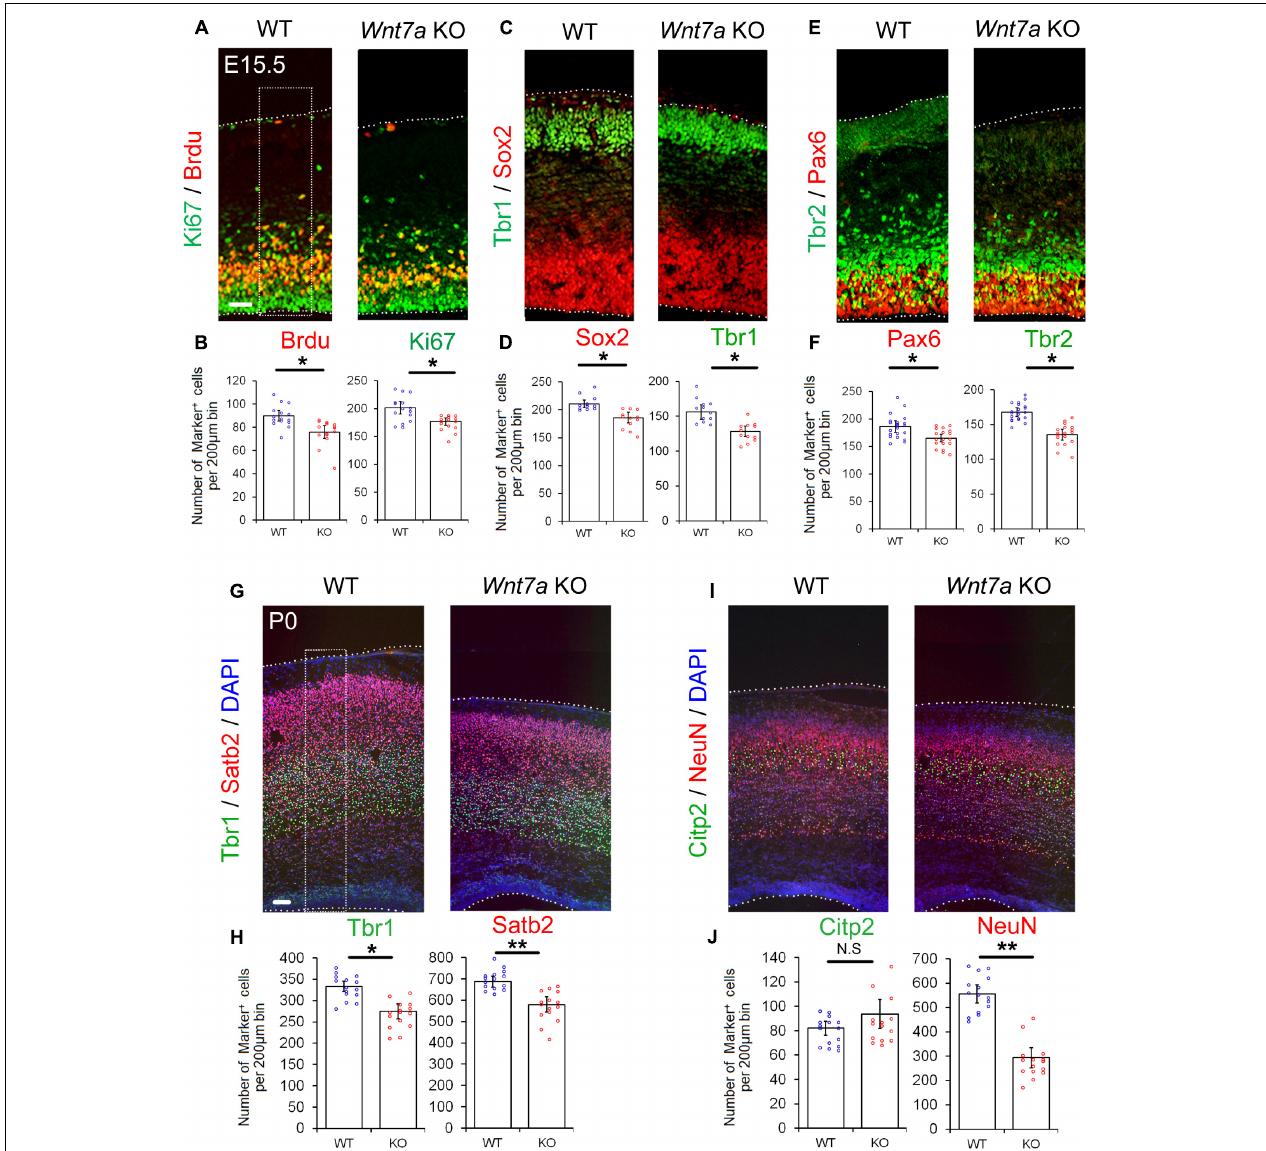
FIGURE 3 | Wnt7a promotes neurogenesis at E15.5 and P0. (A–F) Compared to controls (WT), Wnt7a knockout (KO) cortices at E15.5 displayed a reduction in the numbers of BrdU + , Ki67 + , Sox2 + , Tbr1 + , Pax6 + , and Tbr2 + cells. The dashed box represents the cell counting area. Values of histogram represent mean ± SEM, and each dot represents a data point of the counting number in each section (200 µ m bin). n = 3, at least four sections from each brain. ∗ P < 0.05; unpaired Student’s t -test. (G–J) In P0 Wnt7a KO cortices, the numbers of Tbr1 + and Stab2 + neurons were greatly reduced. NeuN + neurons but not Citp2 + neurons were also reduced. The dashed box represents the cell counting area. Values of histogram represent mean ± SEM, and each dot represents a data point of the counting number in each section (200 µ m bin). n = 3, at least five sections from each brain. ∗ P < 0.05; ∗∗ P < 0.01; ns, non-significant; unpaired Student’s t -test. Scale bar: 100 µ